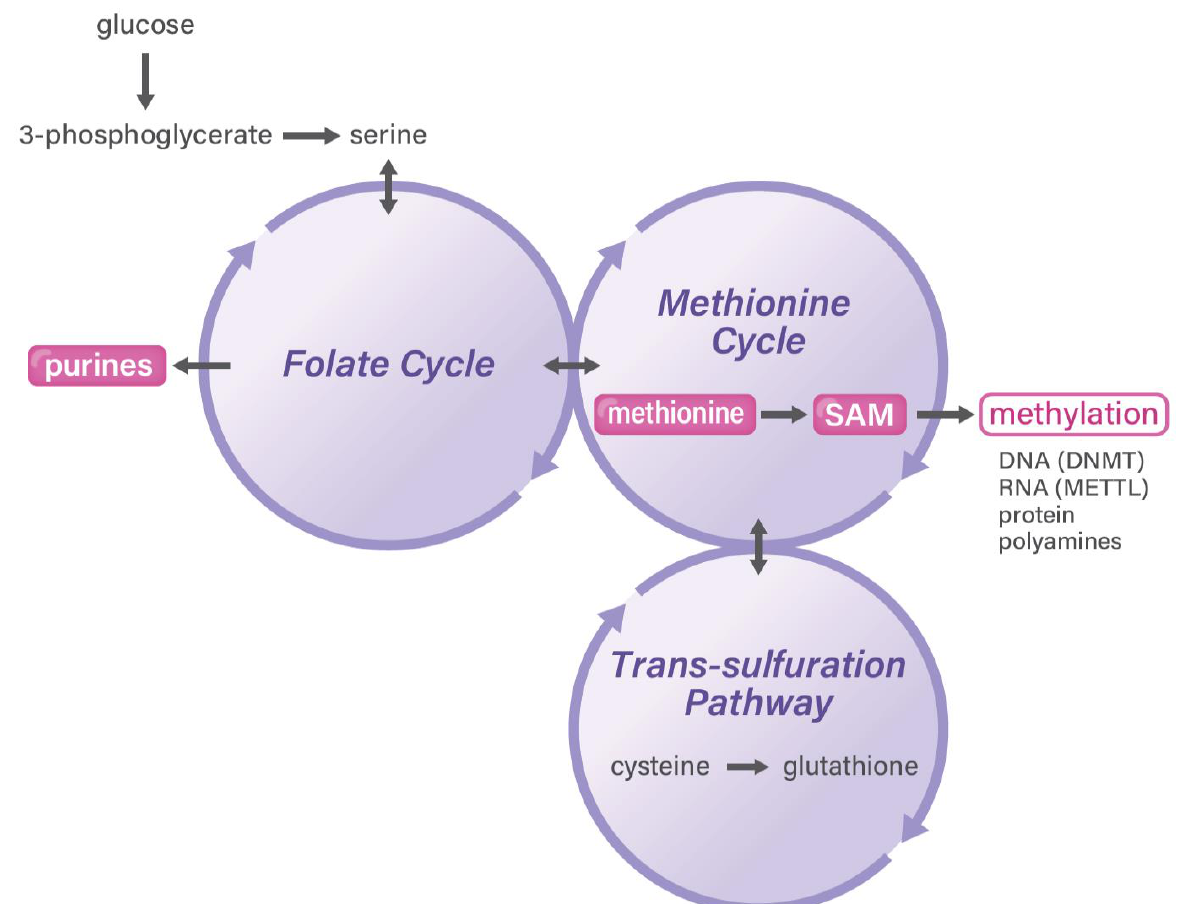
Figure 1. One-carbon metabolism in cancer. One-carbon metabolism is a mechanism that is coupled with three reactions of the folate cycle, methionine cycle, and trans-sulfuration pathway. The circled and highlighted areas indicate those playing a role in cancer and stem cells, as highlighted in the text. DNMT, DNA methyltransferase; METTL, adenosine-methyltransferase.